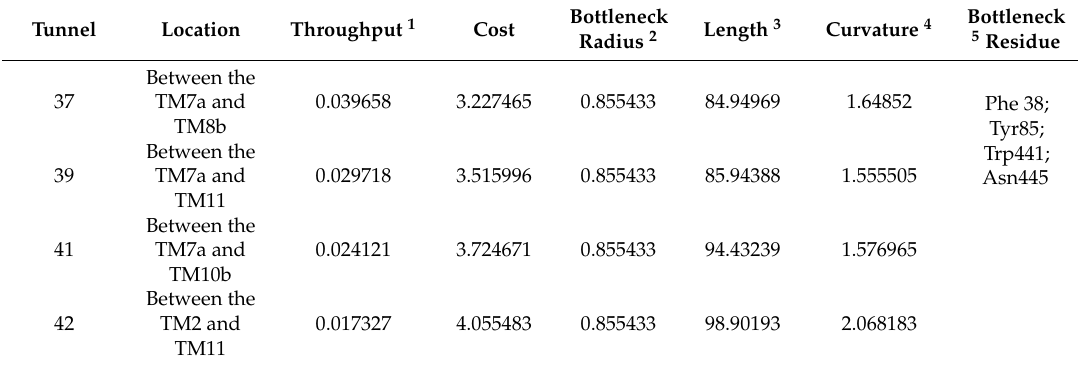
Table 2. Characteristics of the four candidate tunnels of CCM_6358 identified by CAVER 3.0